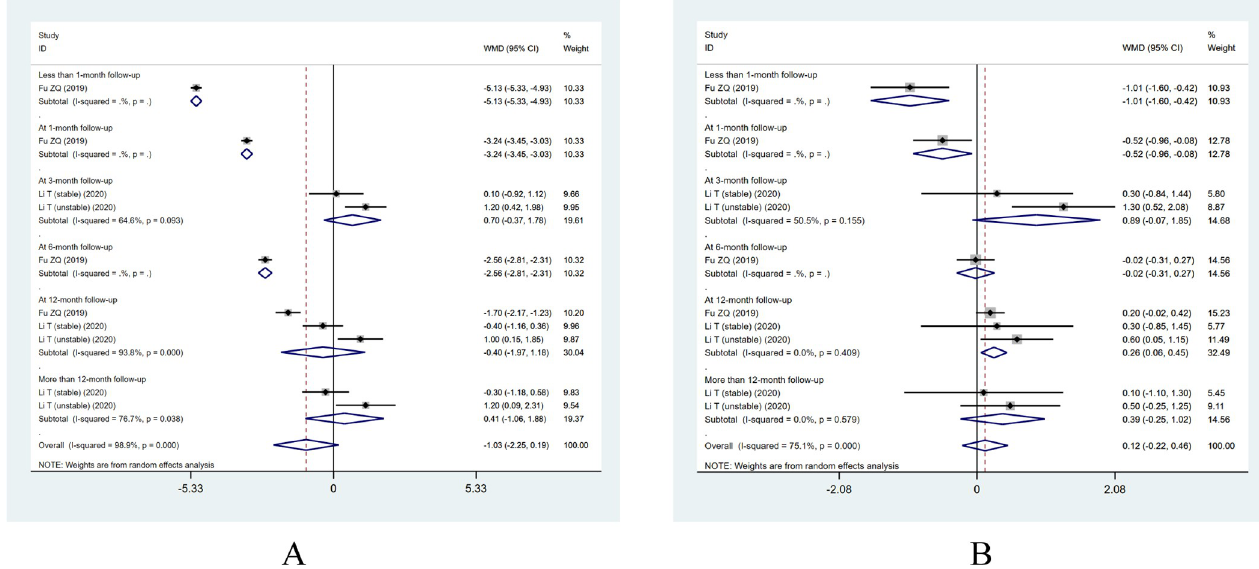
Fig 3. Forest plot of VAS scores. (A) Forest plot of clinical controlled trials of VAS-back scores; (B) Forest plot of clinical controlled trials of VAS-leg scores.